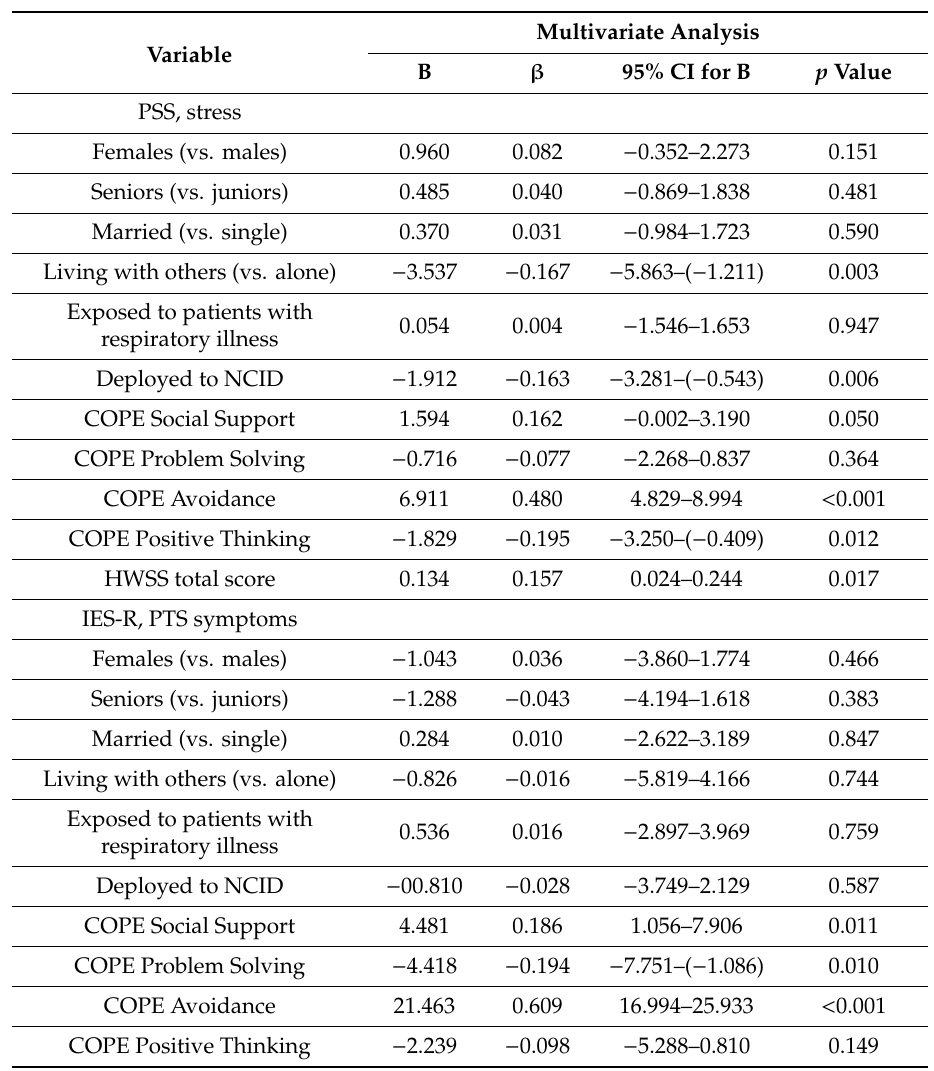
Table 3. Risk Factors for Mental Health Outcomes Amongst Residents in Training from National Healthcare Group Residencies at the 2nd